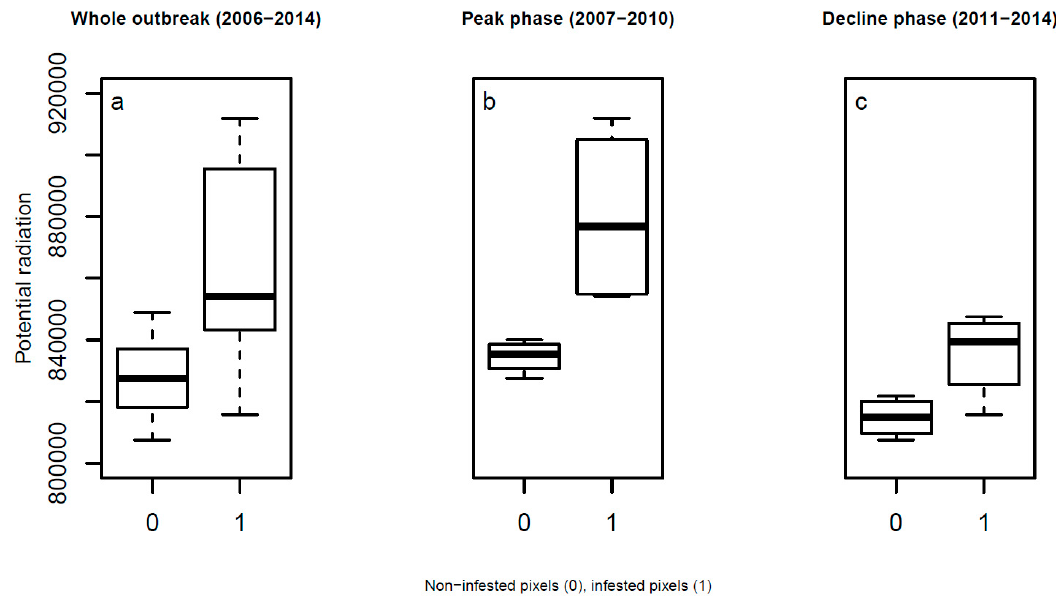
Figure 4. Comparison of potential solar radiation of pixels with noninfested and infested trees during the ( a ) whole bark beetle outbreak (Mann–Whitney U Test: W = 12, p = 0.01), ( b ) the peak phase (ANOVA, F = 9.18, p = 0.02) and ( c ) the decline phase (ANOVA, F = 7.21, p = 0.0363) in the High Tatra Mountains.